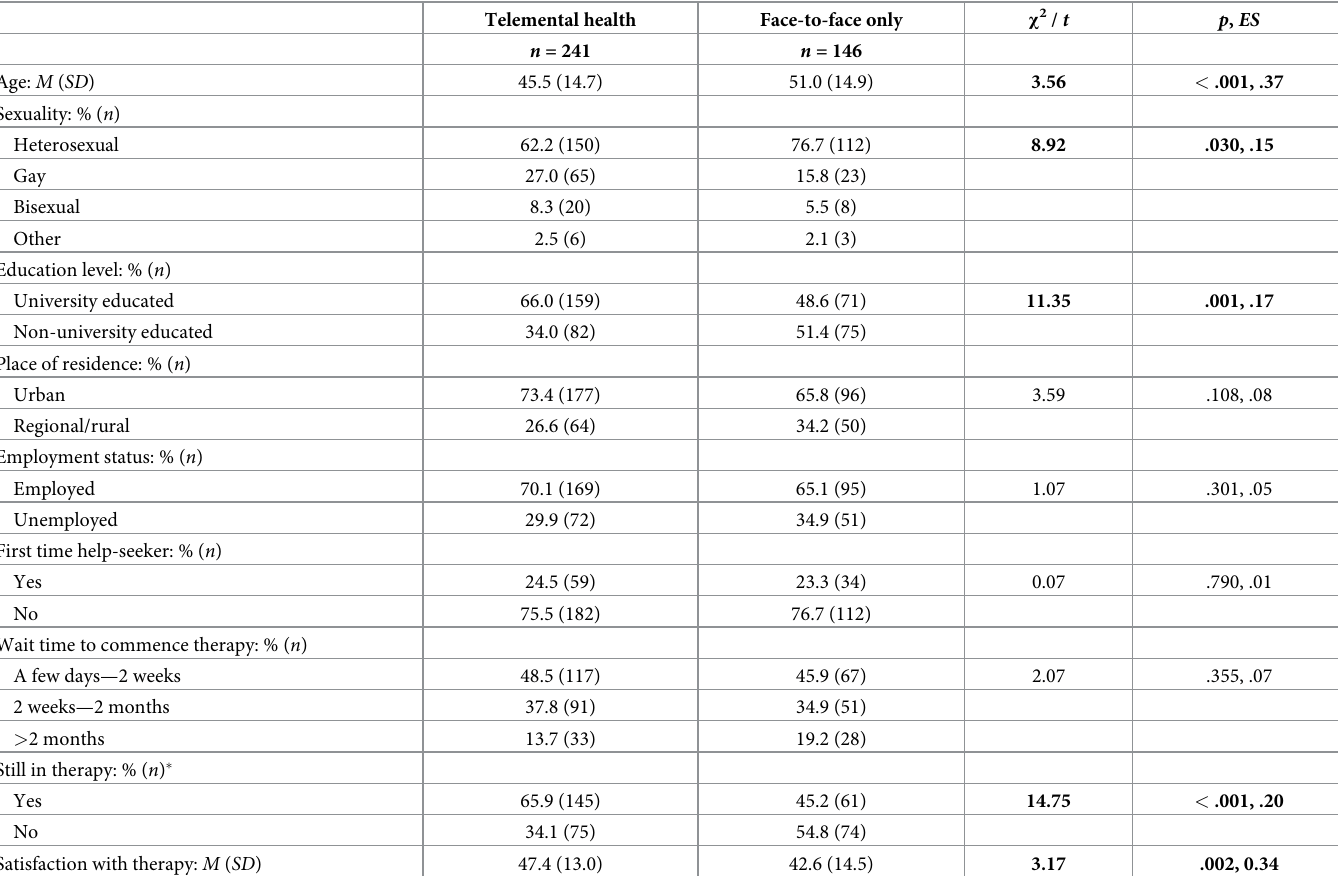
Table 1. Univariate comparisons between users of telemental health and only face-to-face